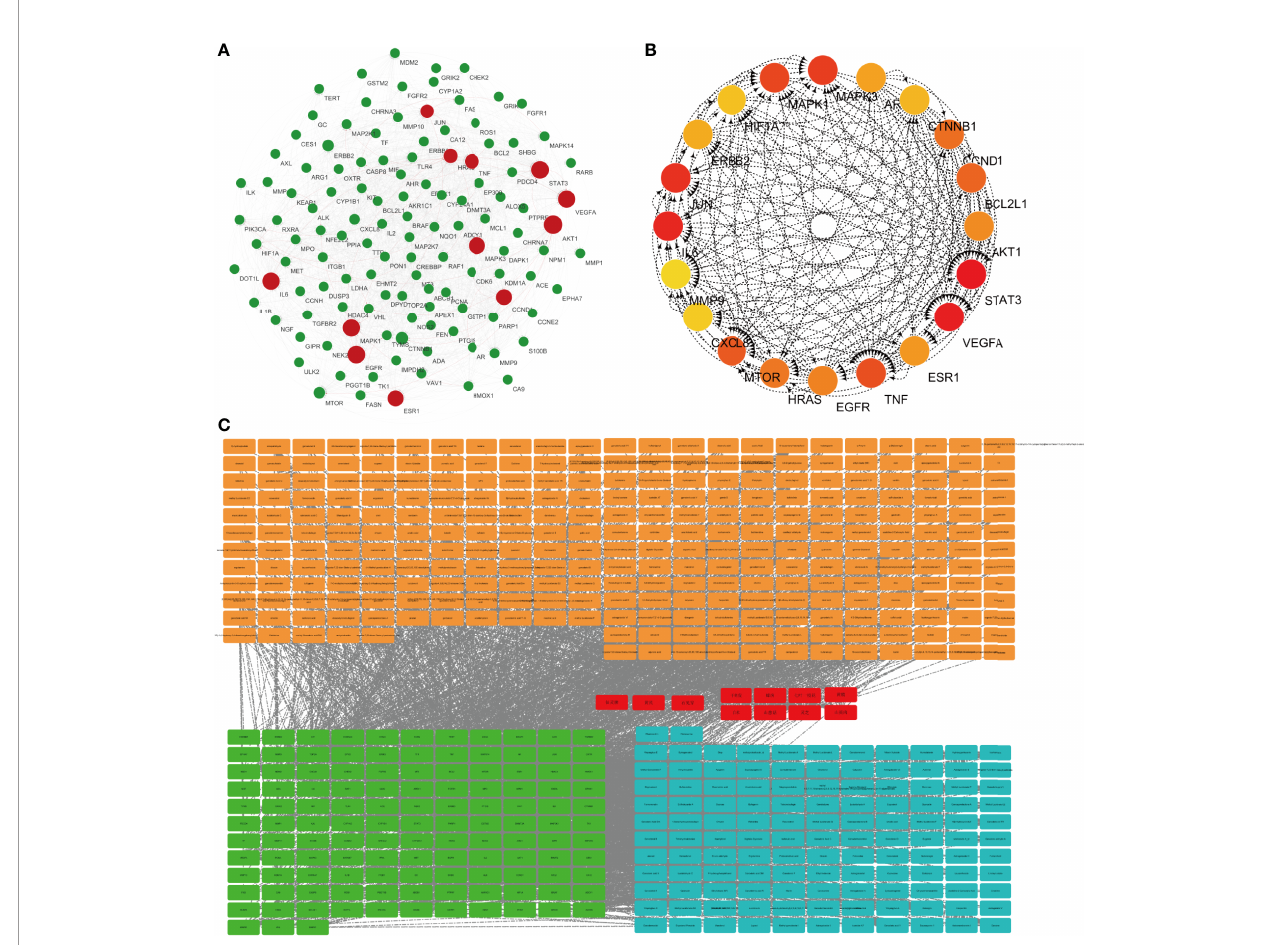
FIGURE 1 | Network pharmacological research of anti-lung cancer target of FYN. (A) PPI map of anti-lung cancer related targets of traditional Chinese medicines. (B) Top 20 network diagram of key targets. (C) Network diagram of traditional Chinese medicine-compound-target (Orange: compounds found in 11 Chinese herbs; Red: 11 Chinese herbs; Green: anti-lung cancer targets of this formula; Blue: compounds corresponding to anti-lung cancer